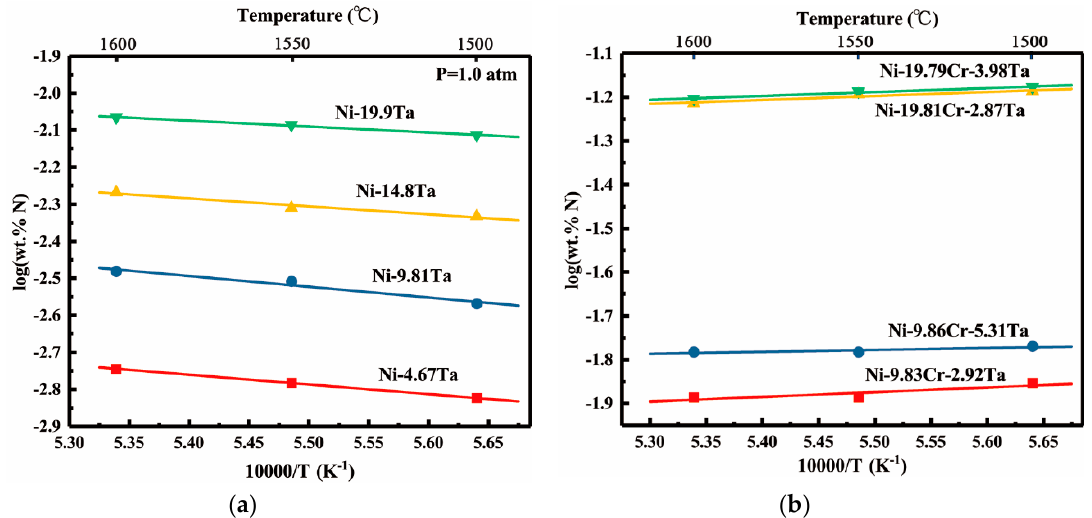
Figure 7. ( a ) The experimental results of the temperature dependence of the nitrogen solubility in liquid Ni-Ta alloys ; ( b ) Experimental results of the temperature dependence of the nitrogen solubility in liquid Ni-Cr-Ta alloys.